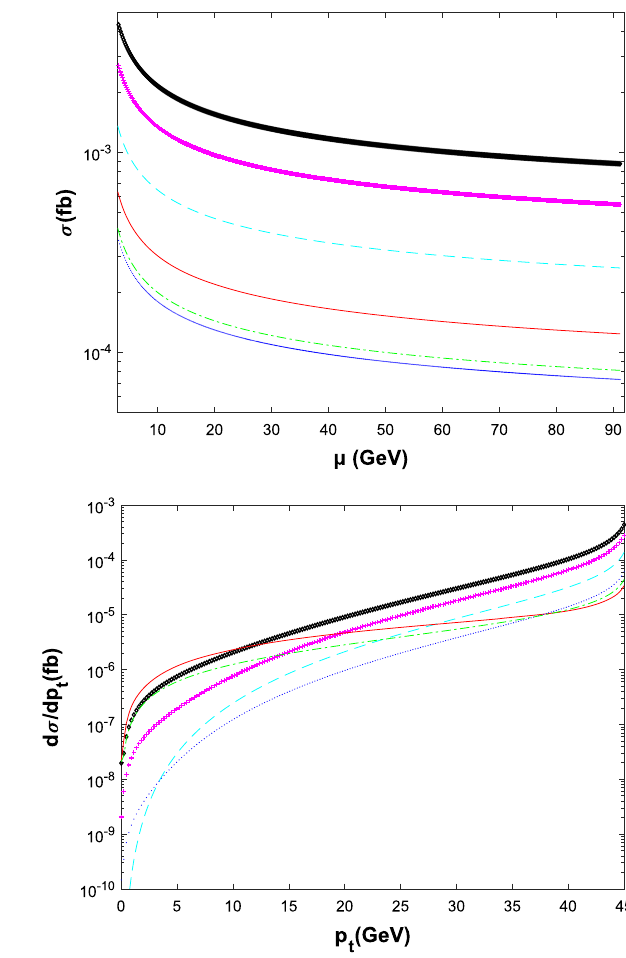
√ s and the renor- line, solid red line, dotted blue line, and the dash-dotted green line are for the top six Z 0 propagated channels in Table 2: J /ψ + h c , η c + χ c 2 , √ η + χ /ψ + J /ψ , η + h /ψ + χ s = m Z for the double charmonium c c 0 , J c c , and J c 2 ,